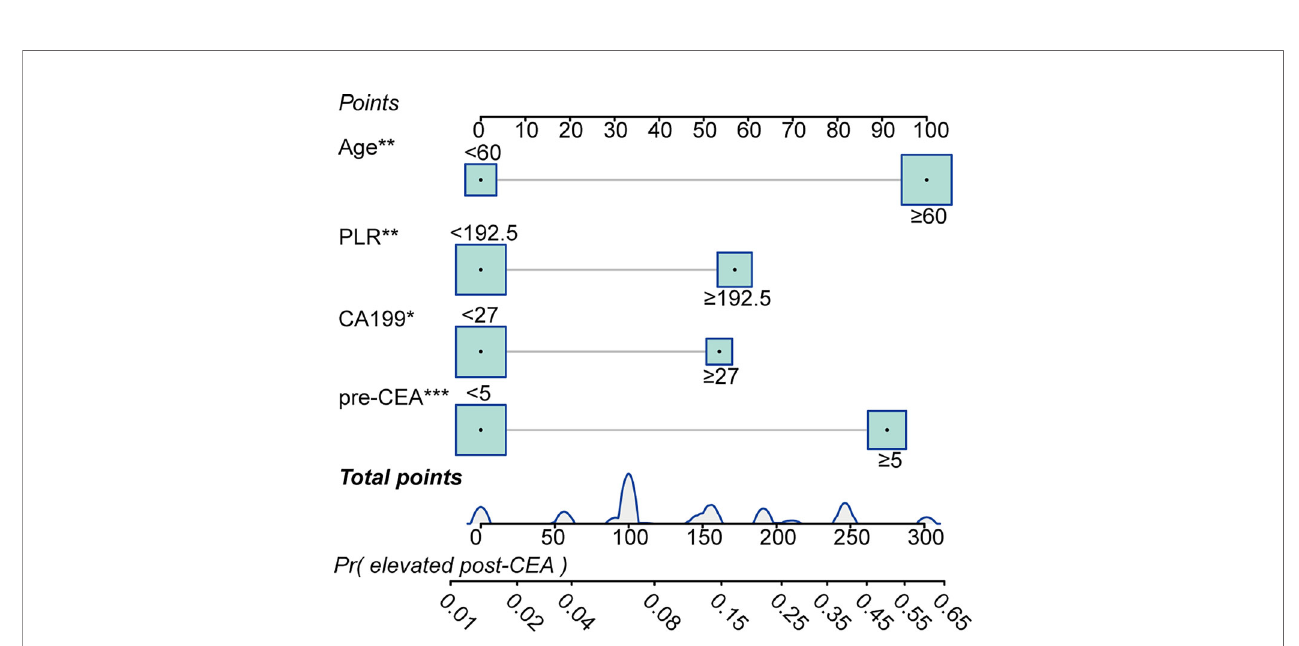
FIGURE 5 | Calibration curves for nomogram predictions. The calibration curves for predicting 1-, 3-, and 5-year overall survival (OS) in the discovery (A) and testing cohort (B) . The calibration curves for predicting 1-, 3-, and 5-year disease-free survival (DFS) in the discovery (C) and testing cohort (D) .